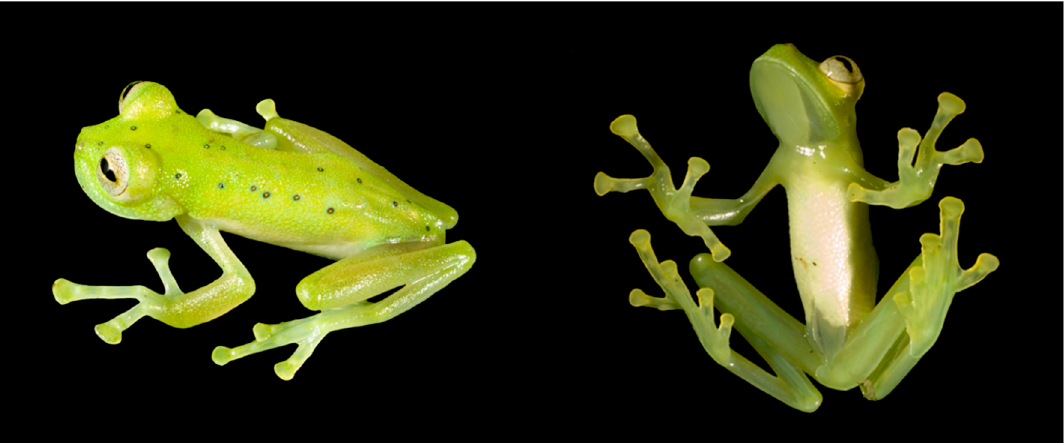
Figure 140. Nymphargus cochranae in life. Ecuador, Volcán Sumaco, 1500 m, QCAZ 31113. Photos by Luis A. Coloma.